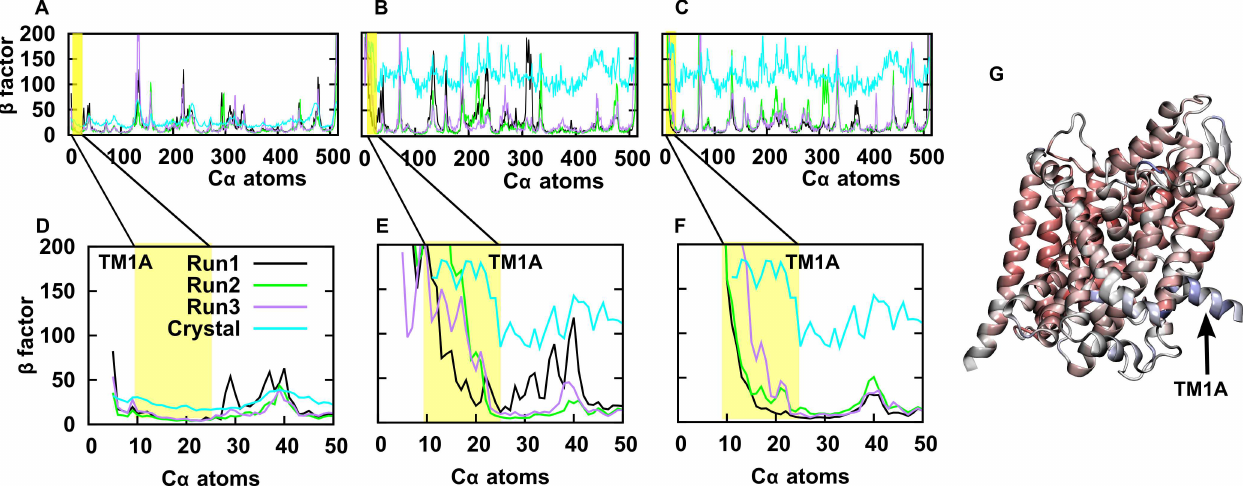
Fig 1. Comparison of residue mobility ( β -factor). Comparison of β -factors extracted from crystal structures (outward-occluded: 2A65; inward-open: 3TT3) with β -factors calculatedfrom MD simulations for (A) the membrane inserted outward-occluded LeuT, (B) membrane inserted inward-open LeuT and (C) micelle inserted inward-openLeuT. (D-F) Zoom into the region of TM1A (highlightedin yellow). The color code of black, green, purple and cyan is used throughout the manuscript to identify respectivelyrun 1, 2, 3 and the crystal structure. (G) The structure of the inward-openLeuT is color coded (from red to blue) by β -factors as reported in the crystal structure (PDB ID: